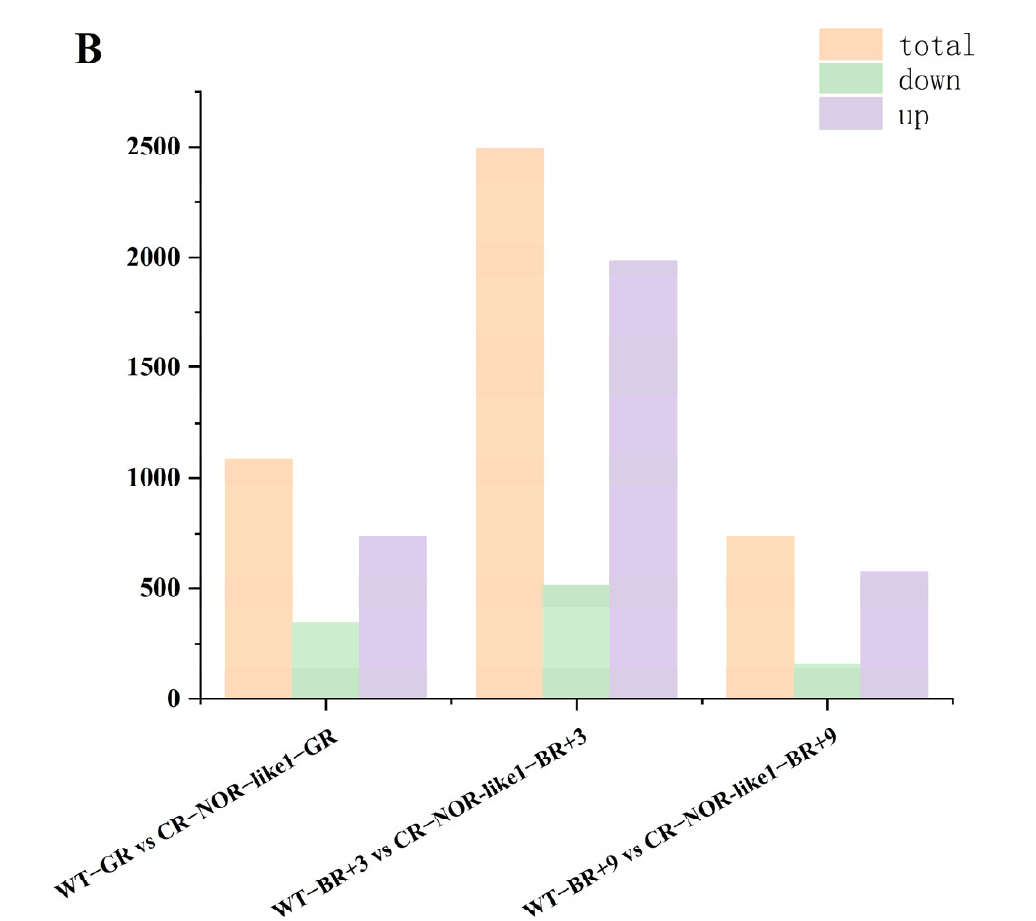
Figure 5. ( A ) The differentially expressed genes in the hierarchical clustering heat map; horizontal coordinates indicate sample names and hierarchical clustering results, and vertical coordinates indicate differential genes and hierarchical clustering results. Red indicates high expression; green indicates low expression. ( B ) Numbers of differentially expressed genes.